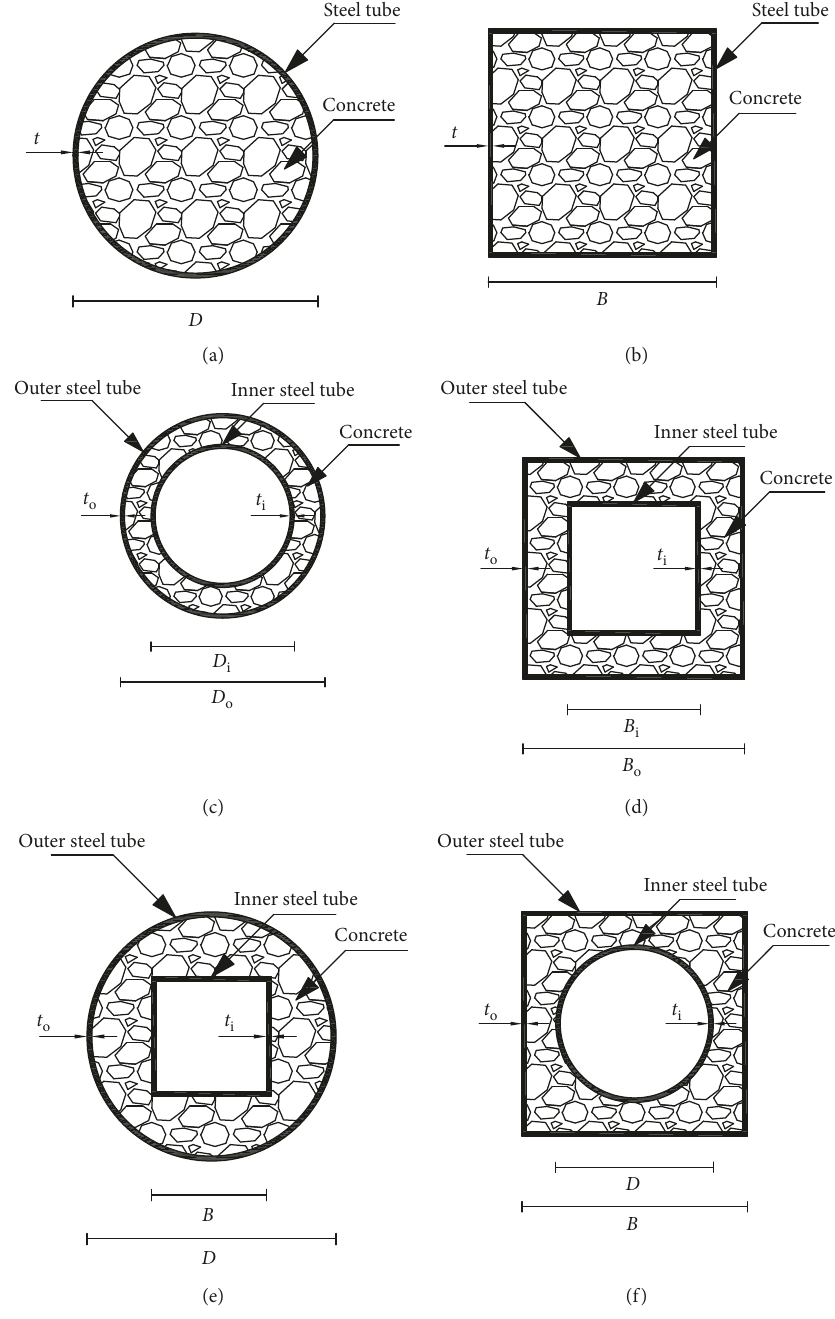
Figure 1: Concrete-filled tubular columns. (a) Single skin circular section, (b) single skin square section, (c) double skin circular outer and inner tubes, (d) double skin square outer and inner tubes, (e) double skin circular outer and square inner tubes, and (f) double skin square outer and circular inner